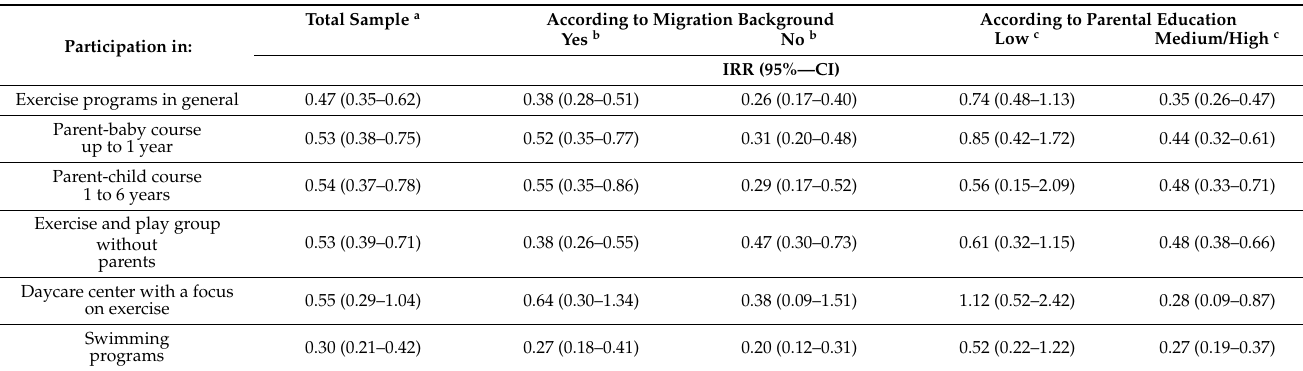
Table 4. Incidence Rate Ratios for a Finding in the Visual-Motor